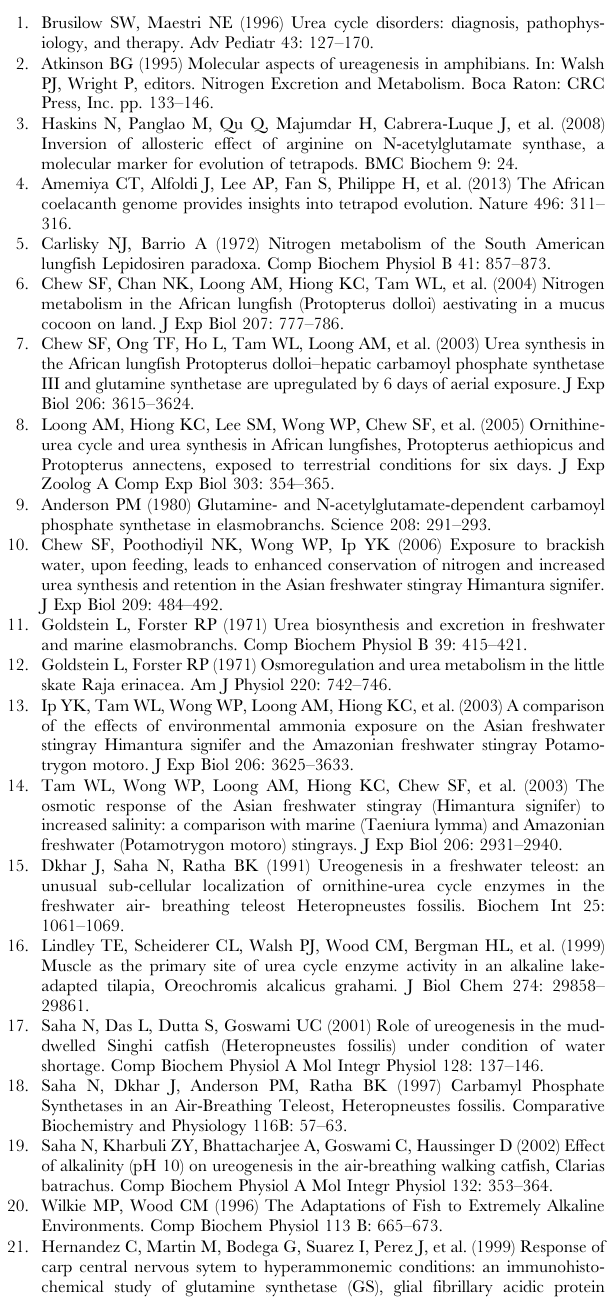
Figure S1 Dependence of the rate of reaction catalyzed by zebrafish NAGS proteins on the concentrations of AcCoA and glutamate. When AcCoA concentration was